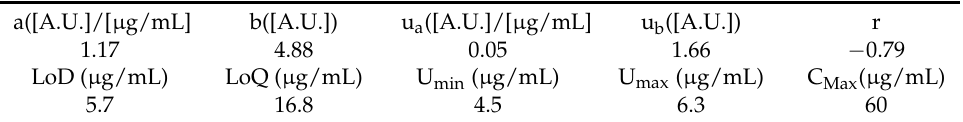
Table 2. Numerical values of the parameters of Figure 6.